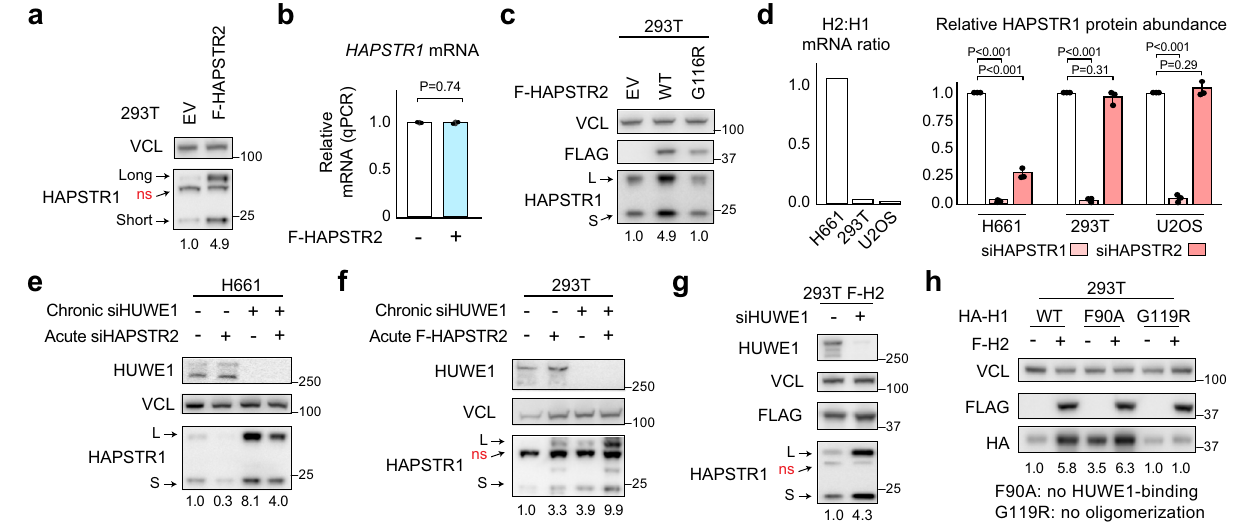
Fig. 4 | HAPSTR2 stabilizes HAPSTR1 through a direct physical interaction. a , b Expression of FLAG-tagged (F)-HAPSTR2 increases endogenous HAPSTR1 protein abundance in 293T cells ( a ) without affecting HAPSTR1 transcript abun- dance ( b ). Representative of N =5 ( a / b ). Note that HAPSTR1 on immunoblot appears as a long (L) and short (S) isoform with a non-speci fi c (ns) band in between 2 , and that HAPSTR2 augments both isoforms but not the non-speci fi c protein ( a ). Mean ± 95% con fi dence interval (CI), two-tailed t test ( b ). c Hetero- oligomerization is required for HAPSTR2-mediated HAPSTR1 stabilization. N =5. d Effect of HAPSTR2 knockdown on endogenous HAPSTR1 protein abundance